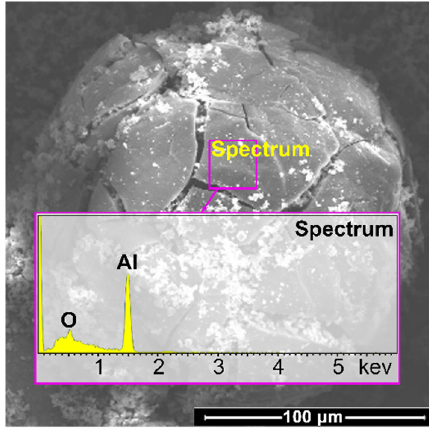
Figure 7. EDS chemical map of CCPs for propellant 2#. Table 3. Elemental composition of CCPs.